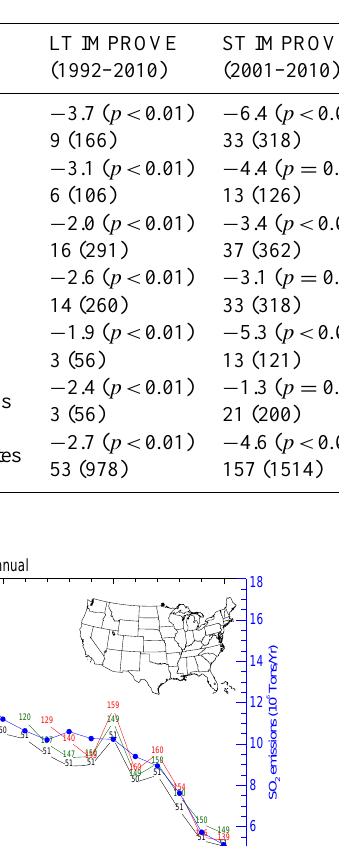
Table 1. Trends in regional, annual mean IMPROVE and CSN particulate sulfate ion concentrations and annual total power plant (CEM) SO 2 emissions. The trend (%yr − 1 ) and significance ( p ) are on top and the number of sites and number of observations (in parentheses) are on the bottom for each region.